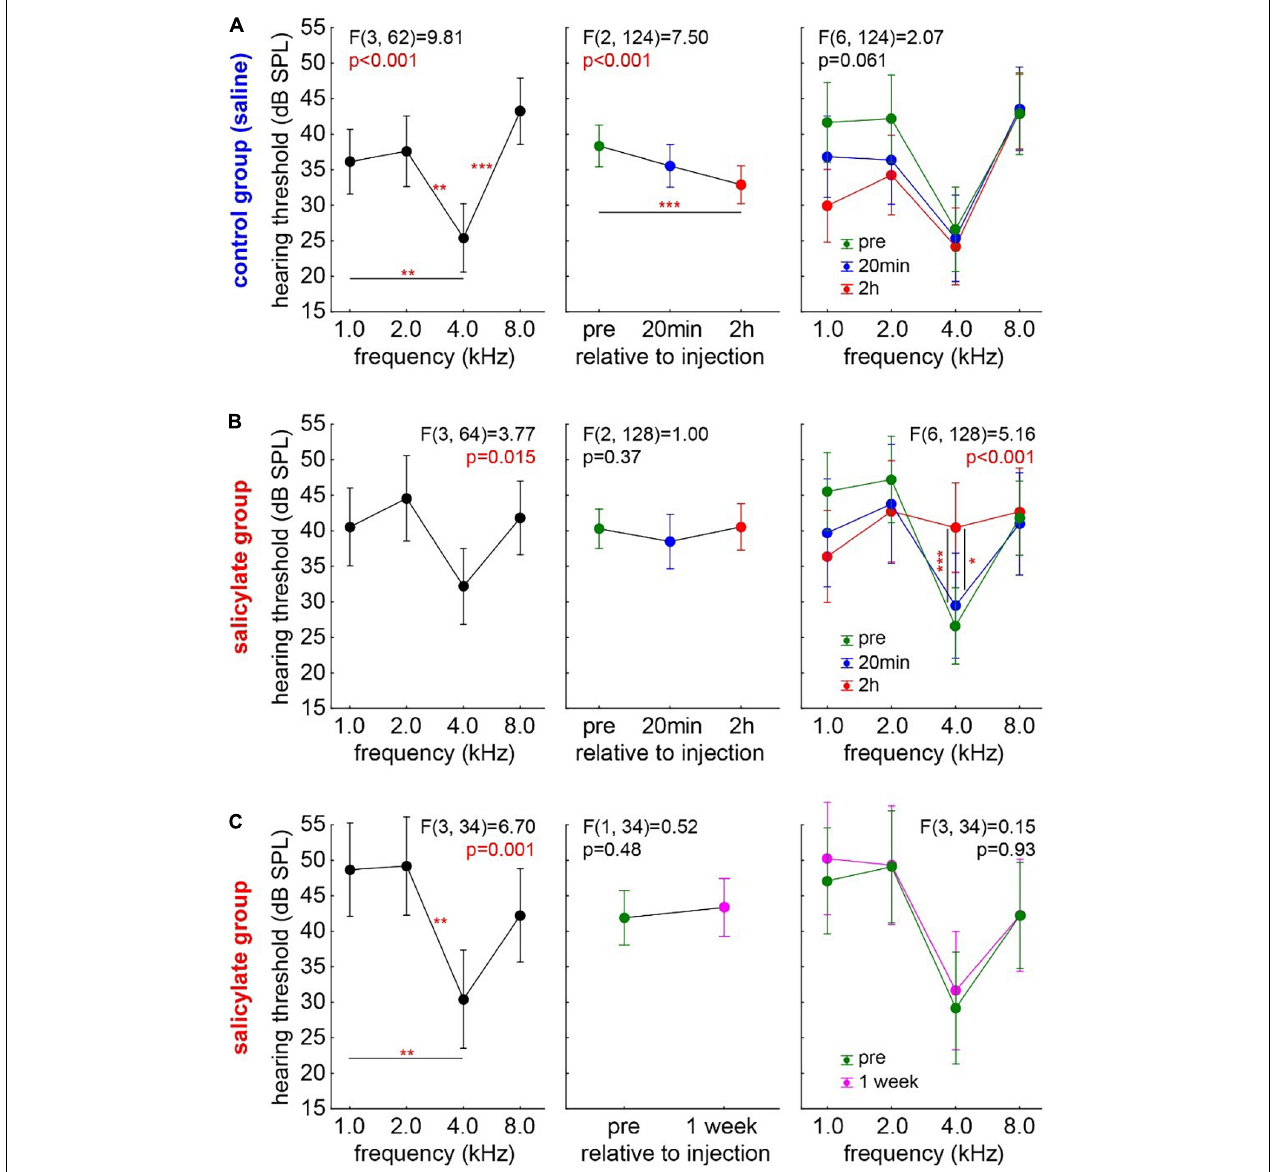
FIGURE 2 | Development of HT over time in both experimental animal groups. One-factorial repeated measurement mixed ANOVA with the factor frequency (left panels) and the repetition factor time (center panels) and interaction of time X frequency (right panels) are shown: (A) Audiogram in the control group (group C, n = 18). Over time, a significant decrease of the frequency-averaged hearing threshold can be observed. No interaction between frequency and time was found. Asterisks indicate a level of Tukey post hoc tests: * p < 0.05, ** p < 0.01, *** p < 0.001. (B) Audiogram in the salicylate group (group S, n = 19). No HT difference over time was found, but a significant interaction of time X frequency was observed with the strongest effect centered around 4 kHz. (C) The transitory effect of the salicylate. No HT differences in the same salicylate animals 1 week post-injection compared with their pre injection recordings.